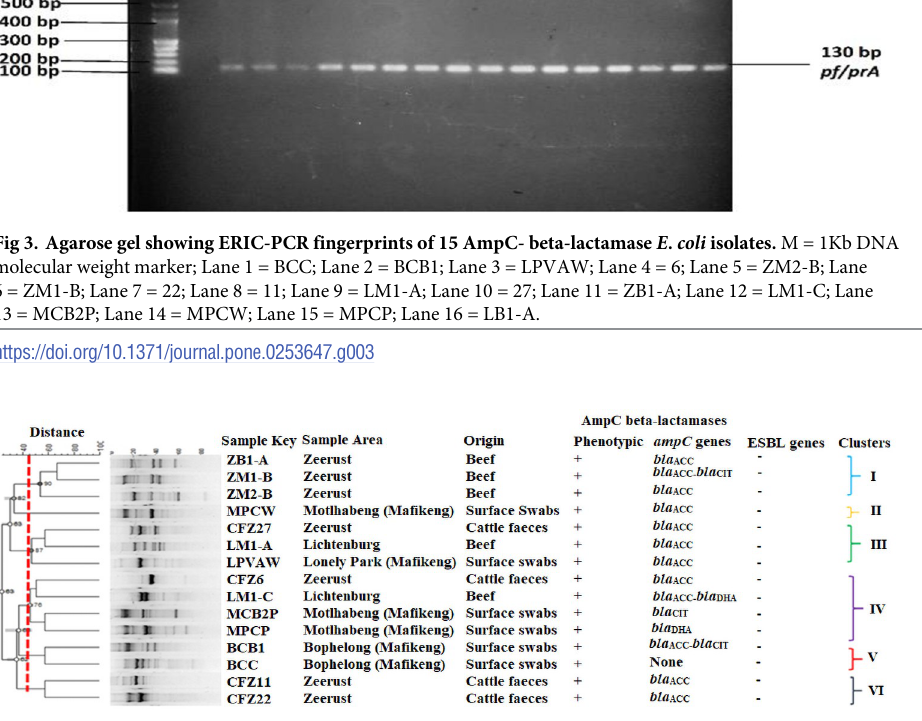
Fig 4. Dendrogram generated from ERIC-PCR cluster analysis of AmpC- beta-lactamase-producing Escherichia coli isolates.